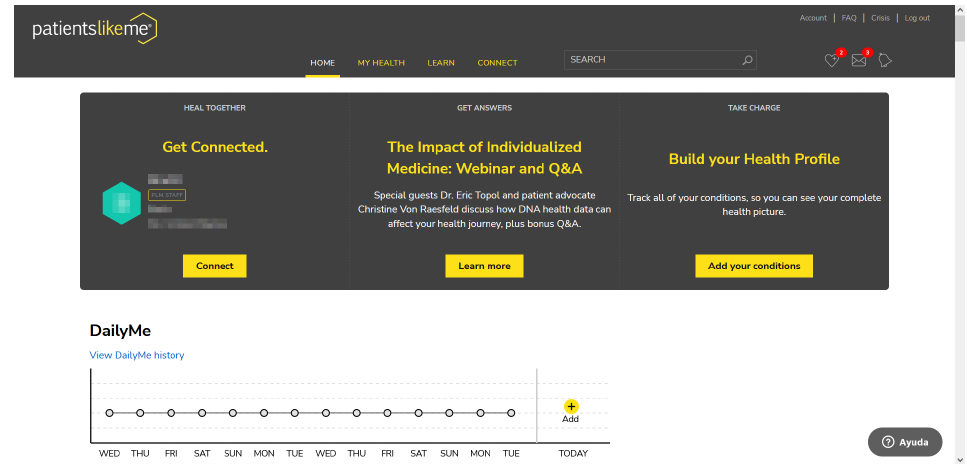
Figure 12. PatientsLikeMe